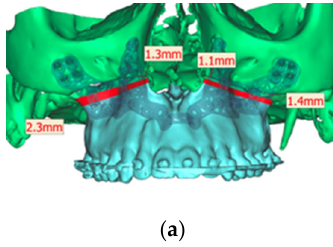
Figure 13. Representation of the segmented maxilla (blue) from the rest of the facial skull (green),